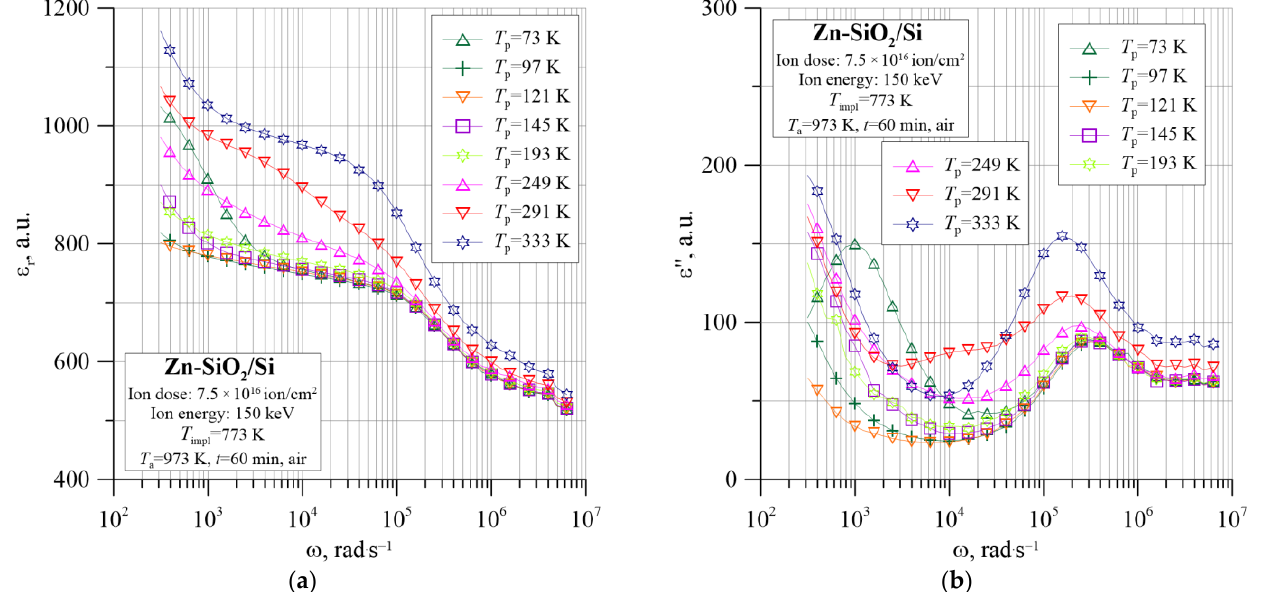
Figure 13. Temperature–frequency dependence of the real ( a ) and imaginary ( b ) part of dielectric permittivity for the Zn-SiO 2 /Si nanocomposite prepared under “hot” implantation conditions (150 keV, 7.5 × 10 16 ion/cm 2 , T impl = 773 K) after